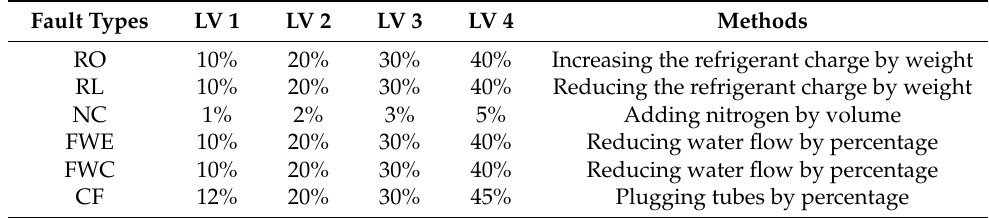
Table 2. Fault types and severity levels.